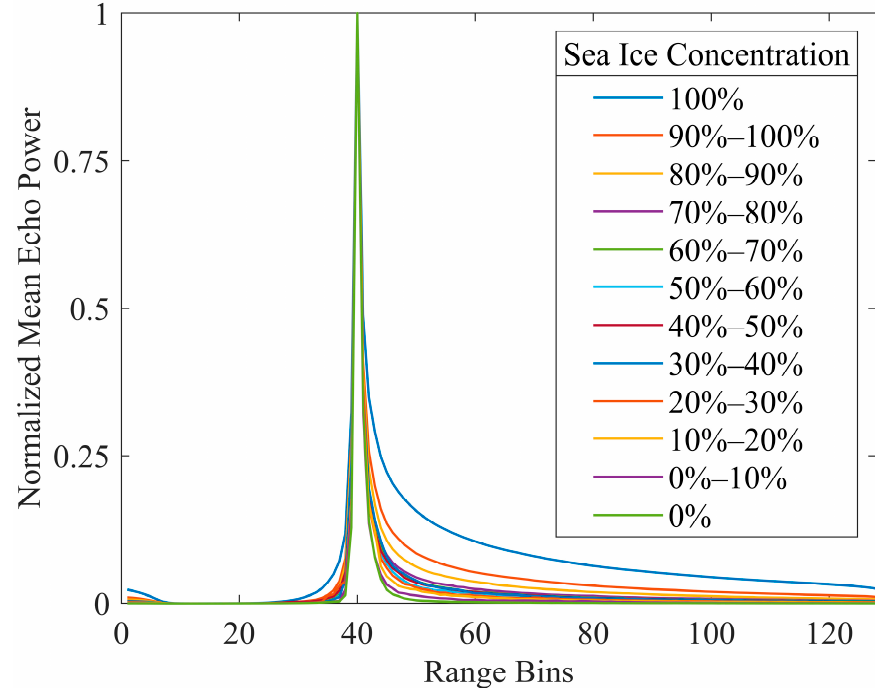
Figure 7. The normalized mean waveforms for different sea ice concentrations.